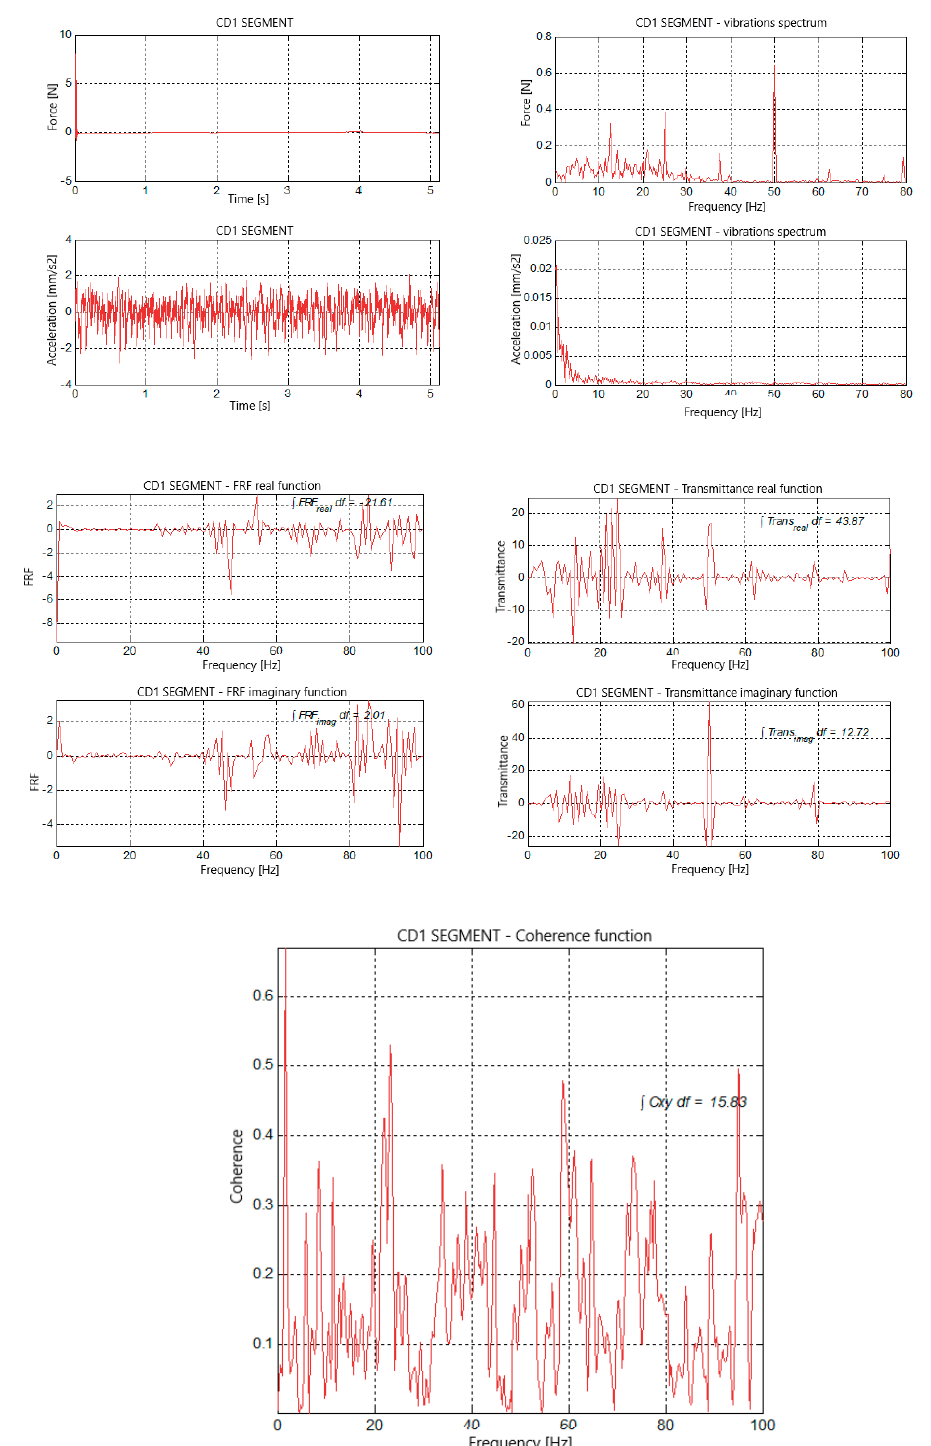
The vibration signal measurements of tested CD1 segments are shown on the X-axis.